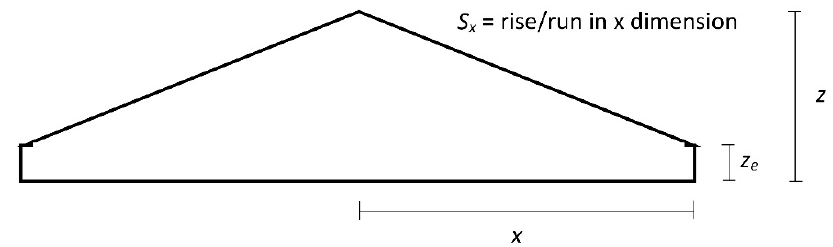
Figure 1. Cross sectional profile for modeled flow down the slope.